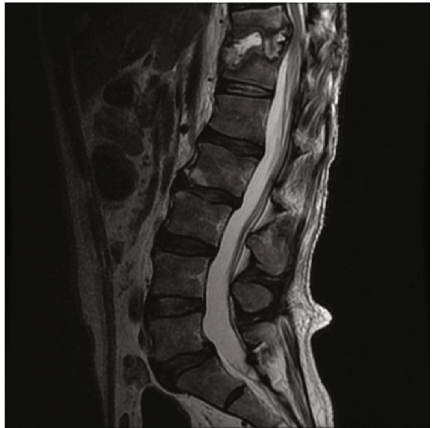
Figure 2: MR thoracic spine T2-weighted image 3 months later demonstrates progression of end plate destruction and phlegmon and progression of spinal stenosis.